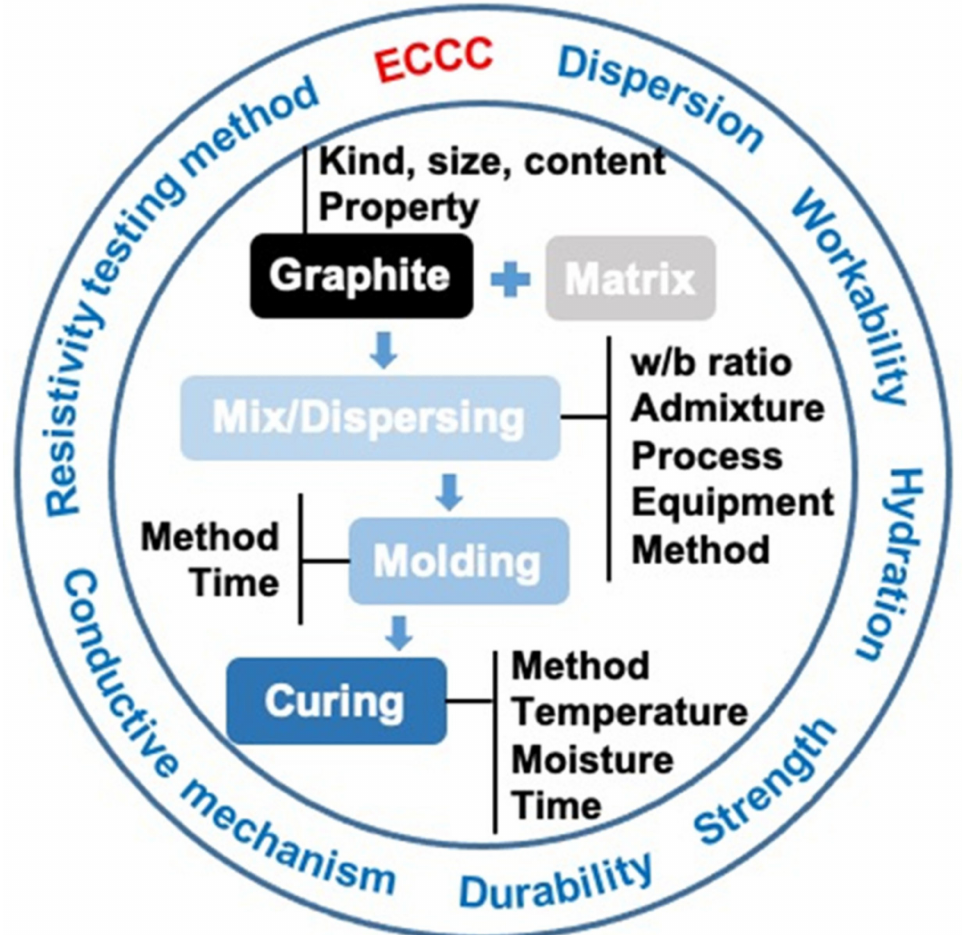
Figure 3. Schematic representation of main topics of this